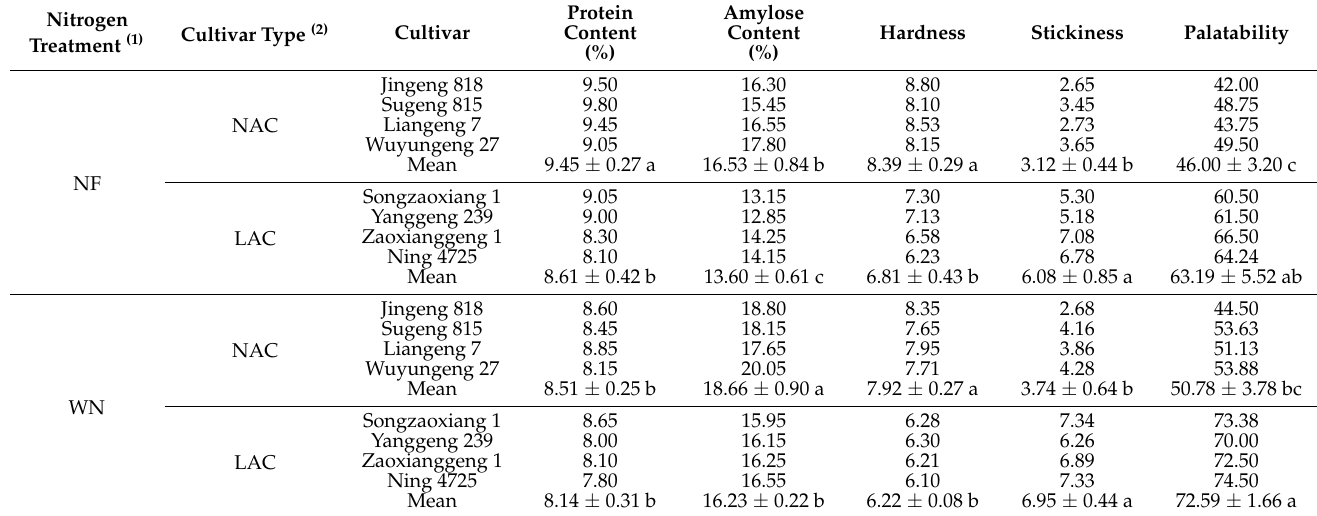
Table 4. Protein content, amylose content, and eating quality of japonica rice cultivars with different contents of amylose, grown with or without nitrogen fertilizer. Nitrogen Treatment